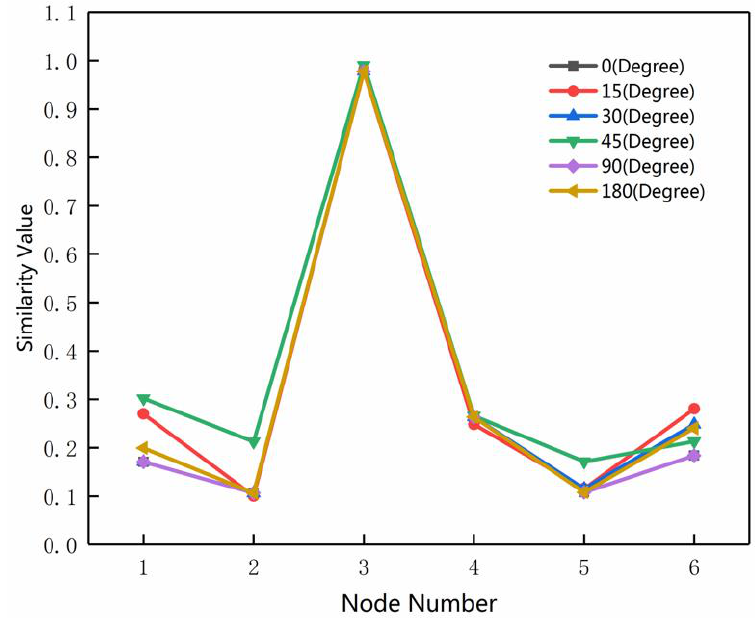
Figure 24. Similarity curves of six pairs of nodes with the same name under di ff erent rotation angles after probability relaxation iteration by using